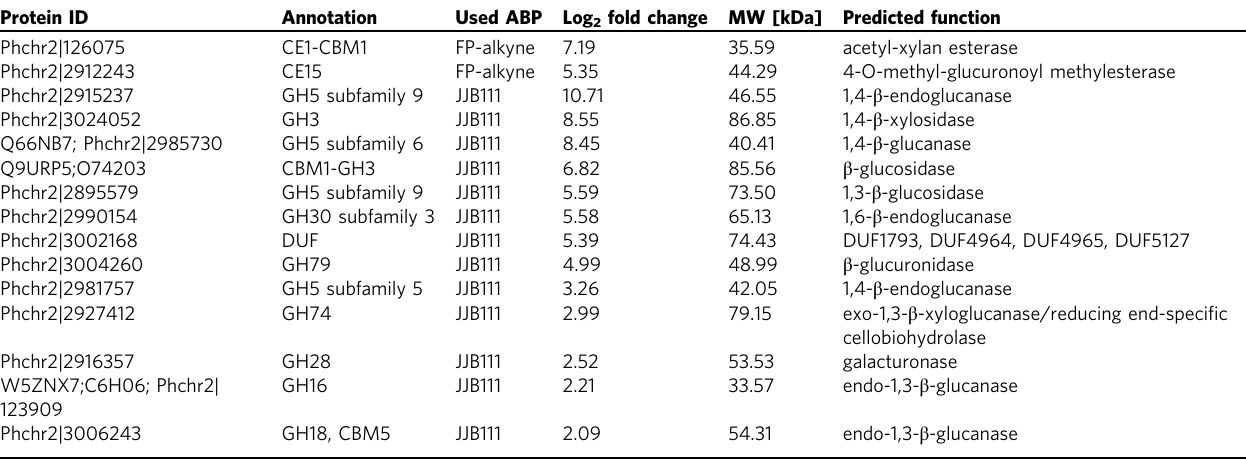
Table 1 Overview of the ABPP-identi fi ed enzymes from pro fi ling the supernatant of P . chrysosporium suspension cultures grown on minimal medium supplemented with beech wood chips. Protein ID